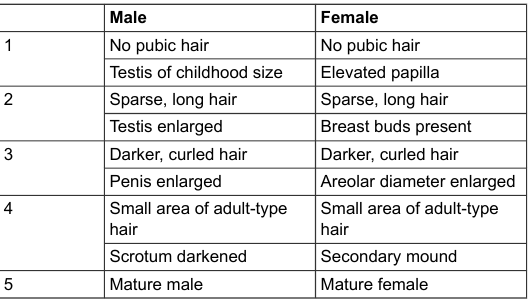
Table 1: Tanner stages evaluating maturity stages [13,